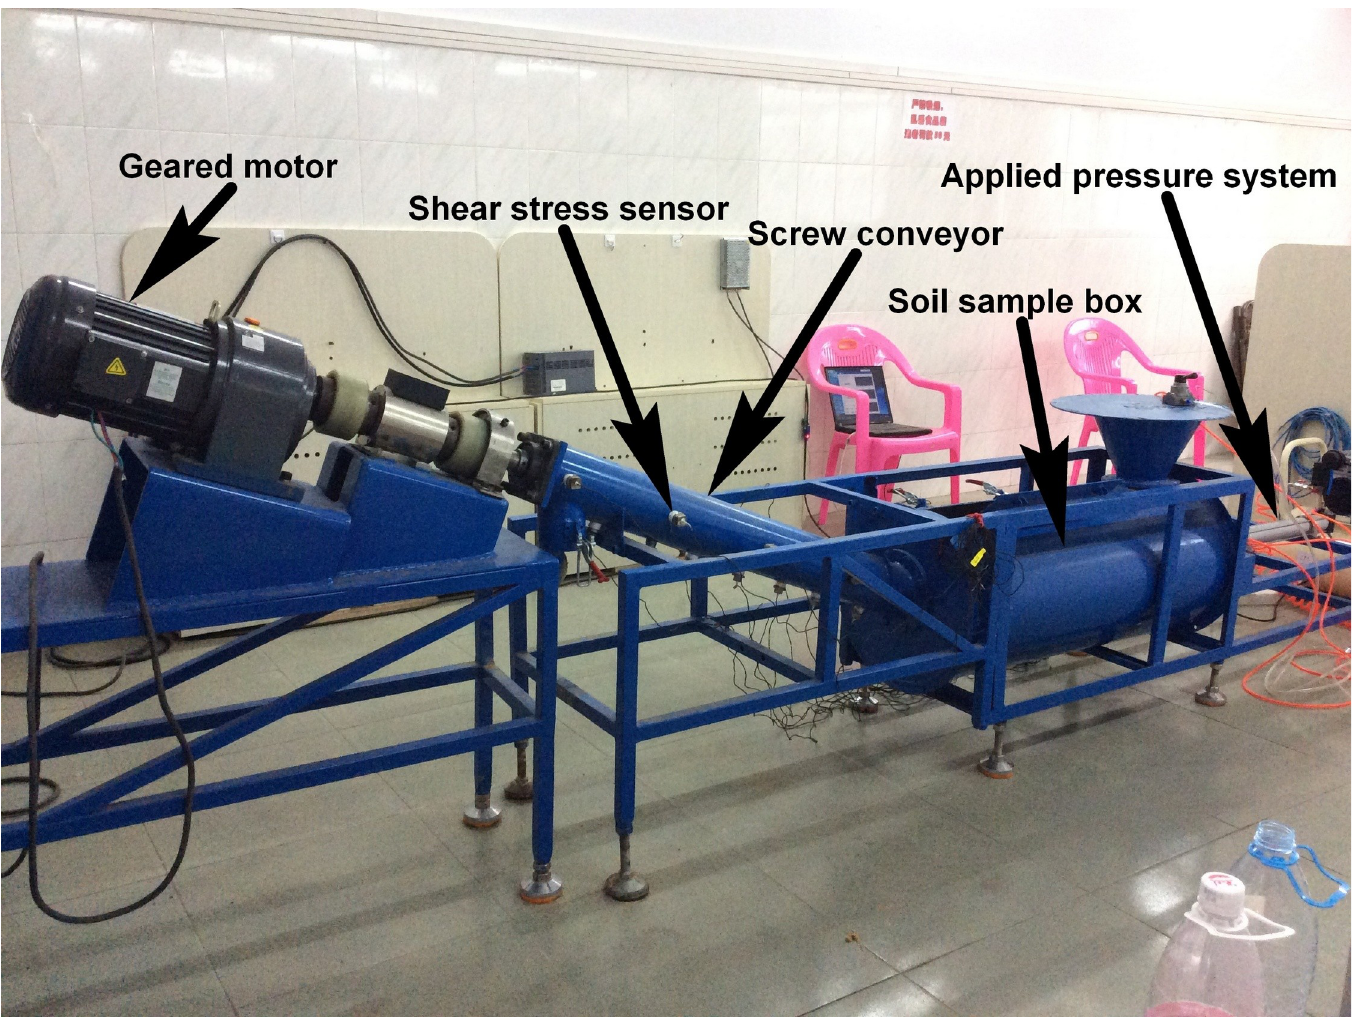
Fig 9. Screw conveyor model machine.